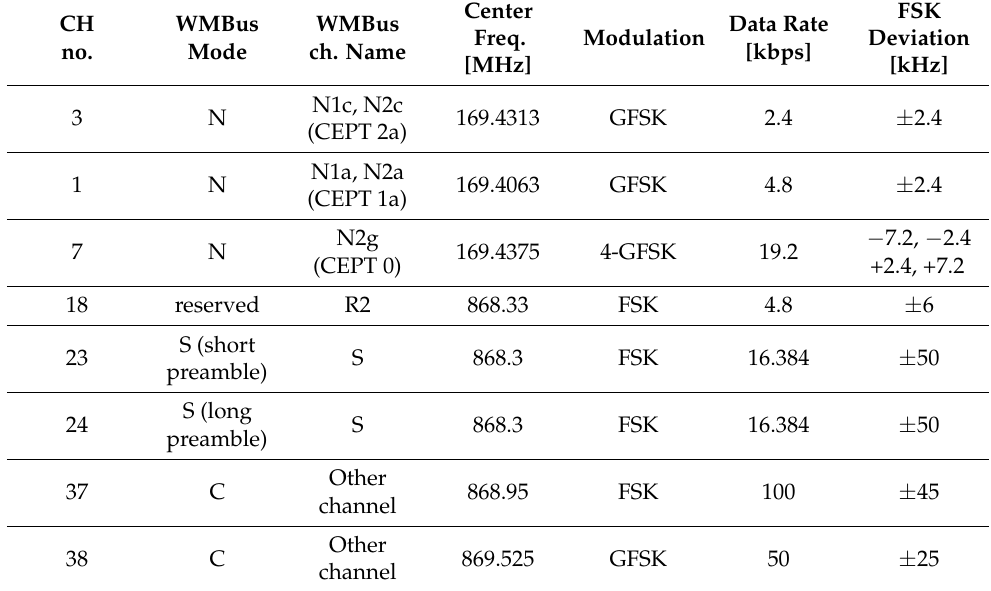
Table 3. The transmission modes used during